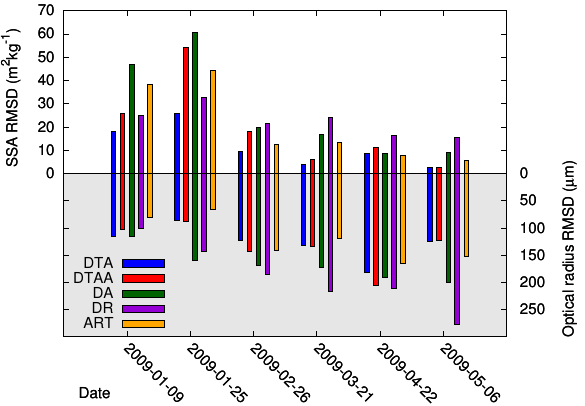
Fig. 8. RMSD to SAFRAN-Crocus of DTA (blue), DTAA (red), DA (green), DR (purple), ART (orange); in SSA (up) and optical radius (down), over the six studied dates.